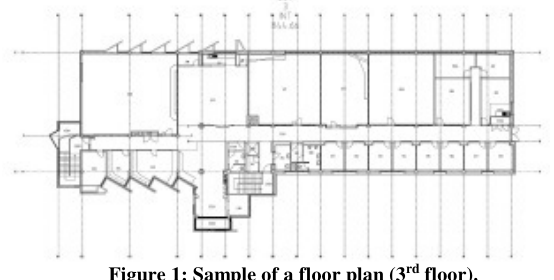
Figure 1: Sample of a floor plan (3 rd floor).